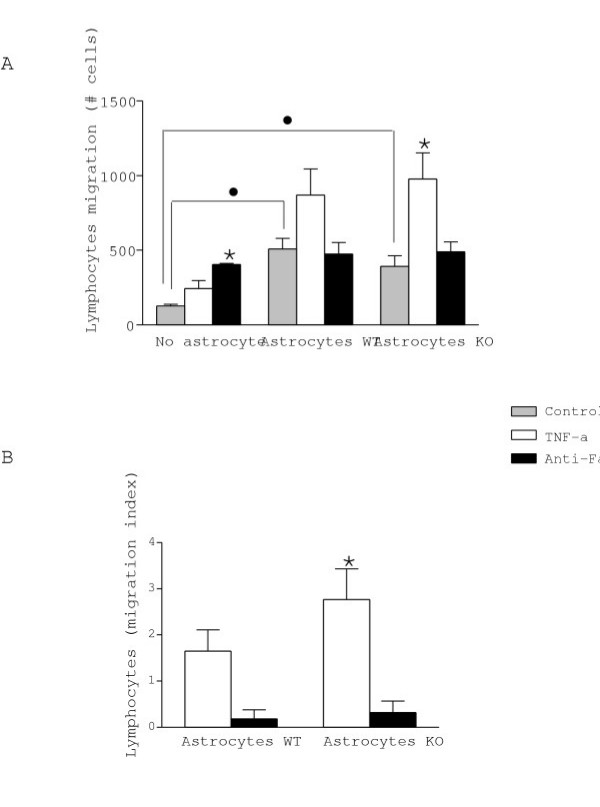
The effect of astrocytes on lymphocyte migration was assessed using Transwell chambers and was expressed by the total number of migrated cells (A) and as an index of migration (B). Note that anti-Fas treatment alone without astrocytes in the lower compartment induced lymphocyte migration. Only KO astrocytes treated with TNF-α induced significant lymphocyte migration. Values represent the mean +/- s.e.m. of at least three independent experiments. Statistical differences were determined by Student's t-test when comparing treatments to control cells (* p < 0.05) or astrocytes vs no astrocyte (● p < 0.05).